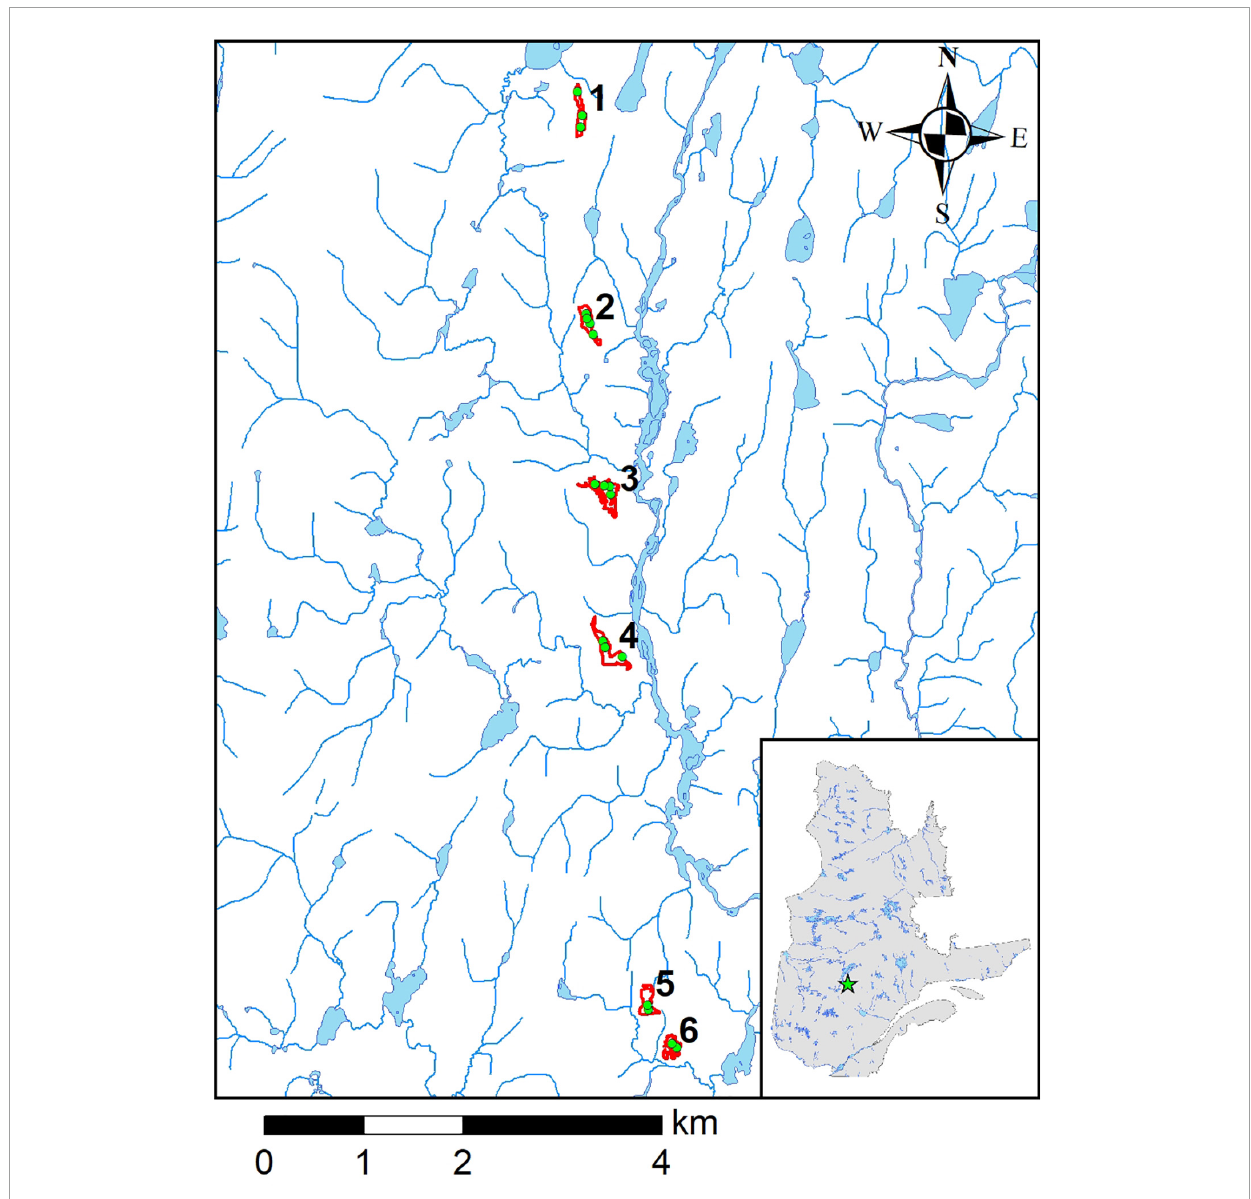
FIGURE1 Location of the six study sites including a total of 18 sampling plots (green dots) in Québec, Canada (50 ◦ 13 (cid:48) 15 (cid:48)(cid:48) N; 73 ◦ 23’27 (cid:48)(cid:48) W).